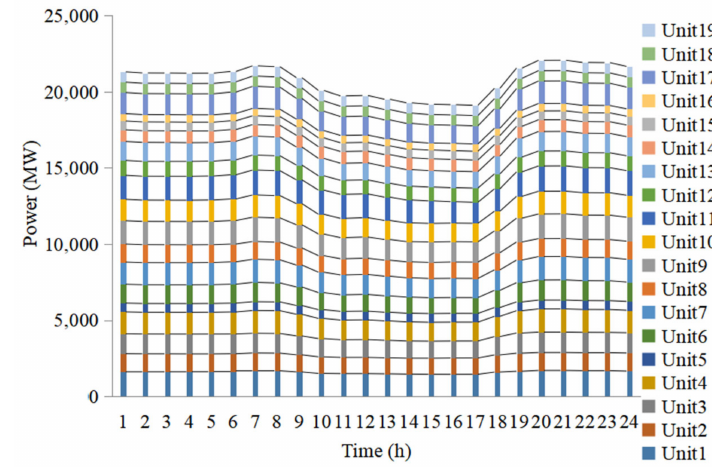
Figure 10. The power outputs of thermal generators in Case 1.